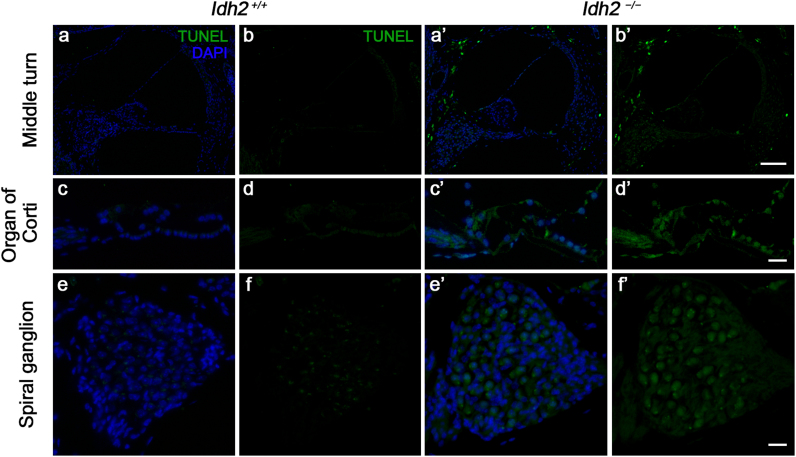
Detection of apoptotic cell death by TUNEL assay in the cochlea fromIdh2+/+andIdh2−/−mice. Apoptotic DNA degradation was analyzed by TUNEL labeling (green) in Idh2+/+ and Idh2−/− mice at 10 months of age, and the nuclei were counterstained with DAPI (blue). Scale bars: 100 µm in (b′) and 20 µm in (d′ and f′).